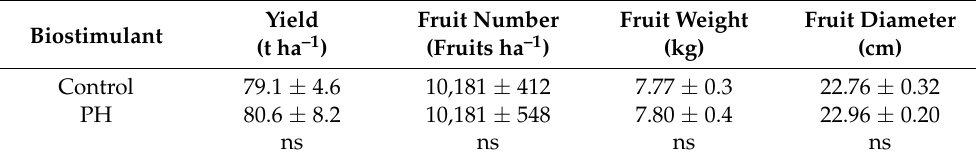
ns = non-significant